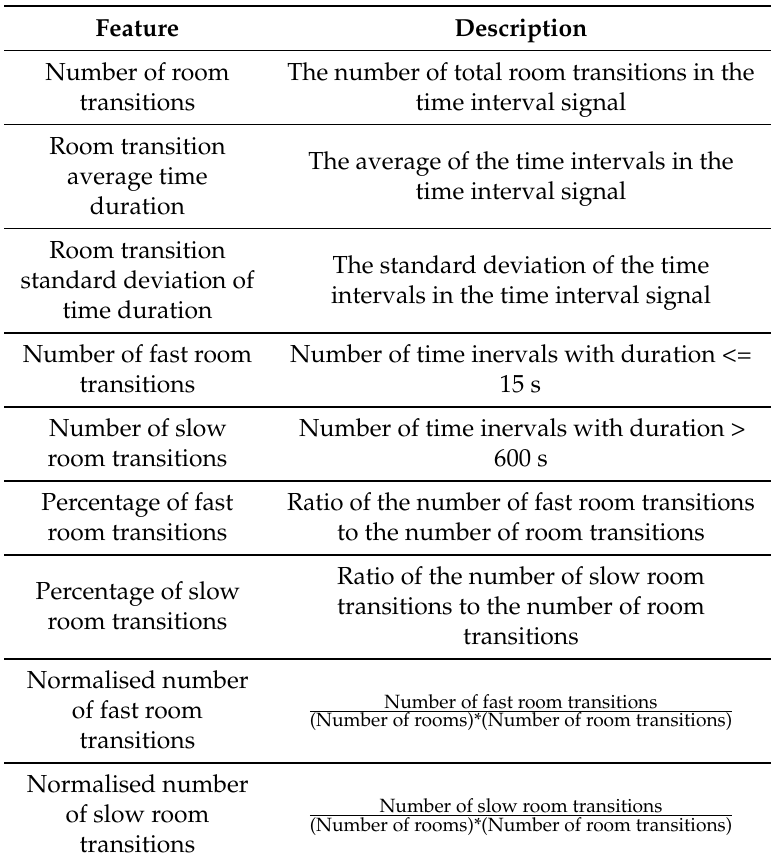
Table 3. Description of the features extracted from each time-interval